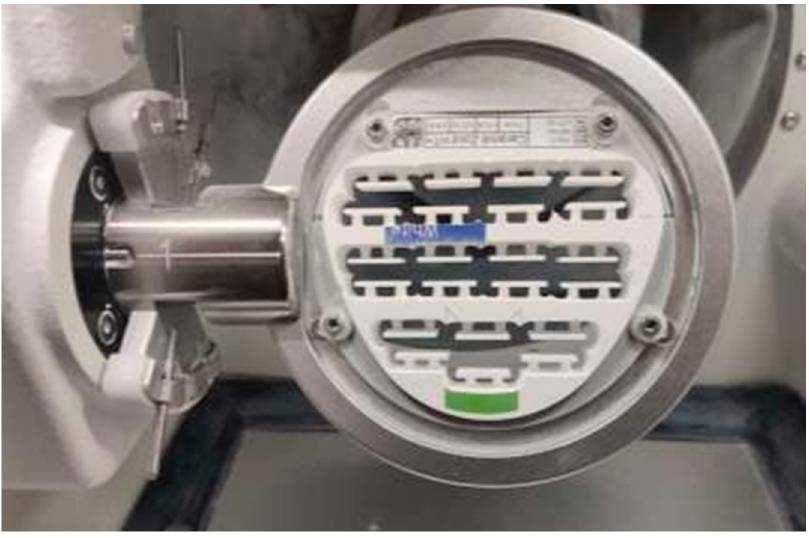
Figure 3. Dry milling of the design was done using a milling machine.